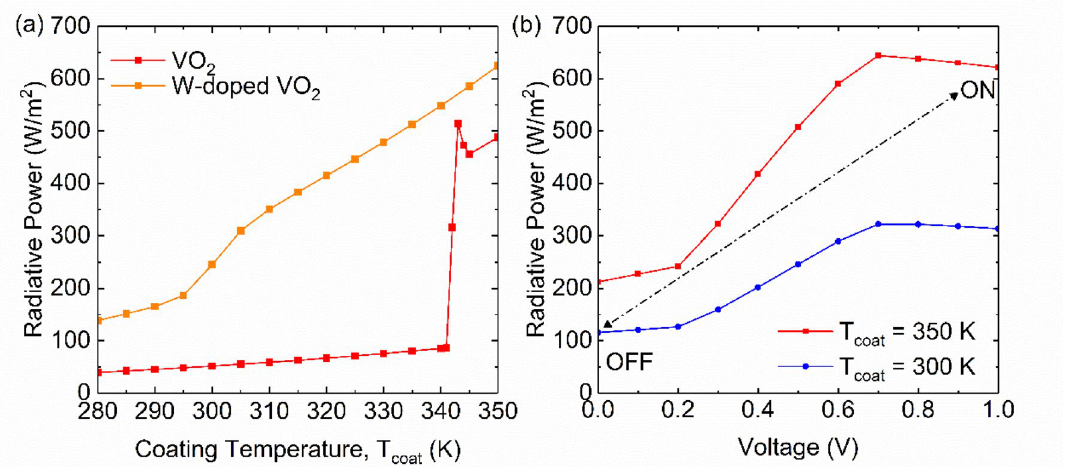
Figure 6. ( a ) Relationship between radiative power and coating temperature for VO 2 and W-doped VO 2 . ( b ) Relationship between radiative power and applied voltage for cWO 3